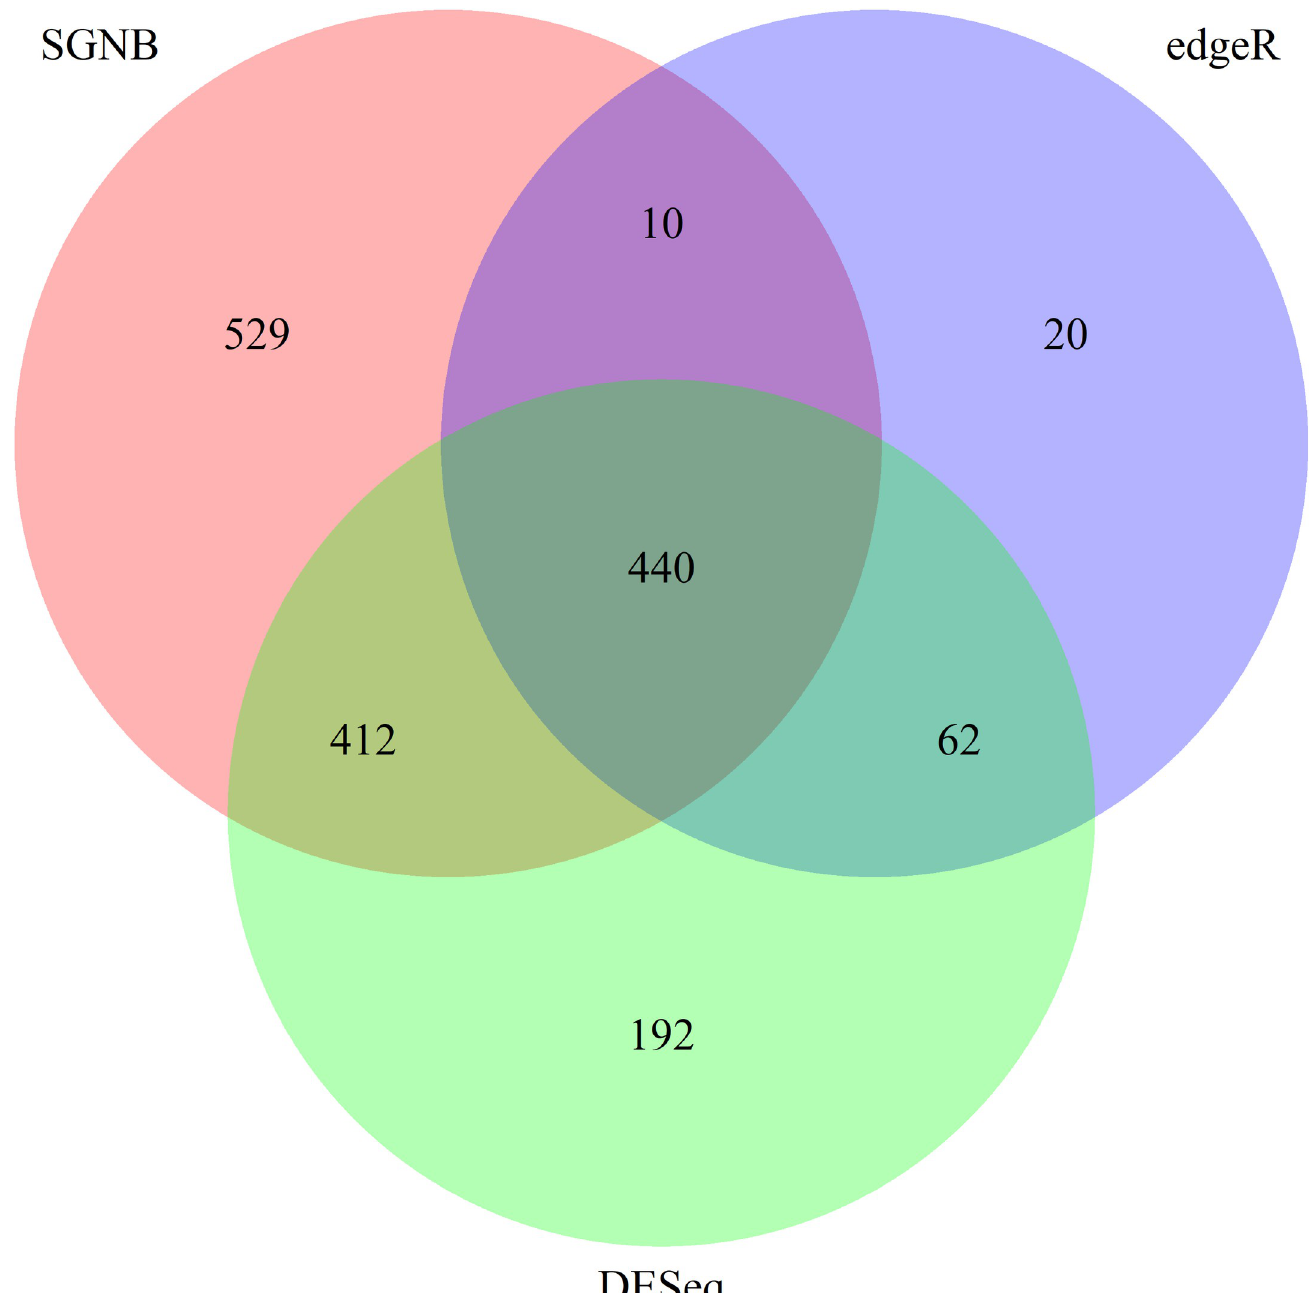
Fig 10. Venn diagram of DE genes detected using different methods. Bonferroni adjustment was made at the significance level of 0.05.